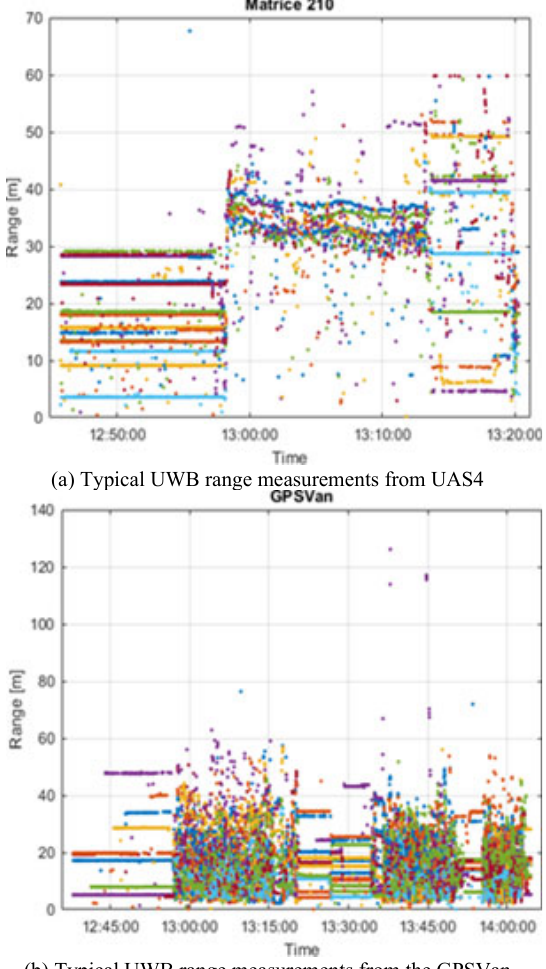
Figure 6 . Typical UWB range data acquired by two platforms First, the self-localization of the ground UWB network was analyzed, using 13 transceivers. The data was acquired in a static mode, and then ranges were used to estimate the relative position of UWB units; i.e., a 2D geodetic network in a local coordinate system. Note that not all possible measurements, (cid:4672) acquired due to environmental limitations. Only about 85% of the ranges were available, which still represented a highly overdetermined system. Using standard least squares adjustment, a 2D solution was computed, as the area is reasonably flat. The internally estimated precision was about 5 cm (1  ). The relative positions of the local network were then compared to the surveyed ground control points. The RMSE obtained was about 10 cm (2D), which is larger than expected but can be explained by two things. First, the network formed by UWB ranges assumed a planar distribution of the locations, while the ground control points were surveyed in 3D with a few-cm accuracy. Second, the tripod setup over the surveyed points and the mounting of the UWB transceivers introduced some mounting bias